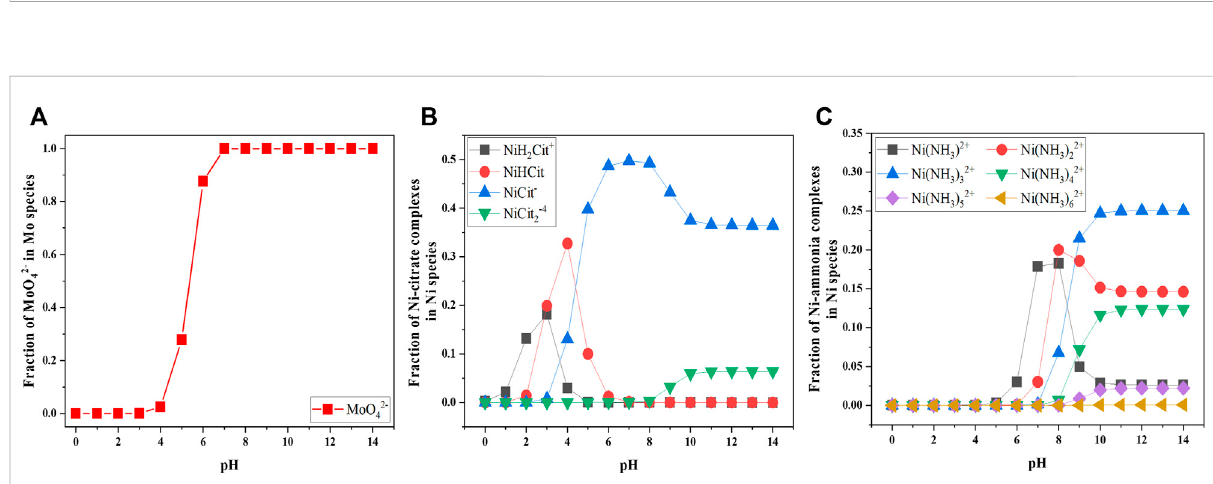
pH range was designated for the effect of NiCit − due to the negligible fraction of Ni(NH 3 ) 3 2+ . In contrast, the alkaline pH at 8 and 10, where different fractions of Ni(NH 3 ) 3 2+ exist, were chosen to investigate the effect of Ni-ammonia complexes.